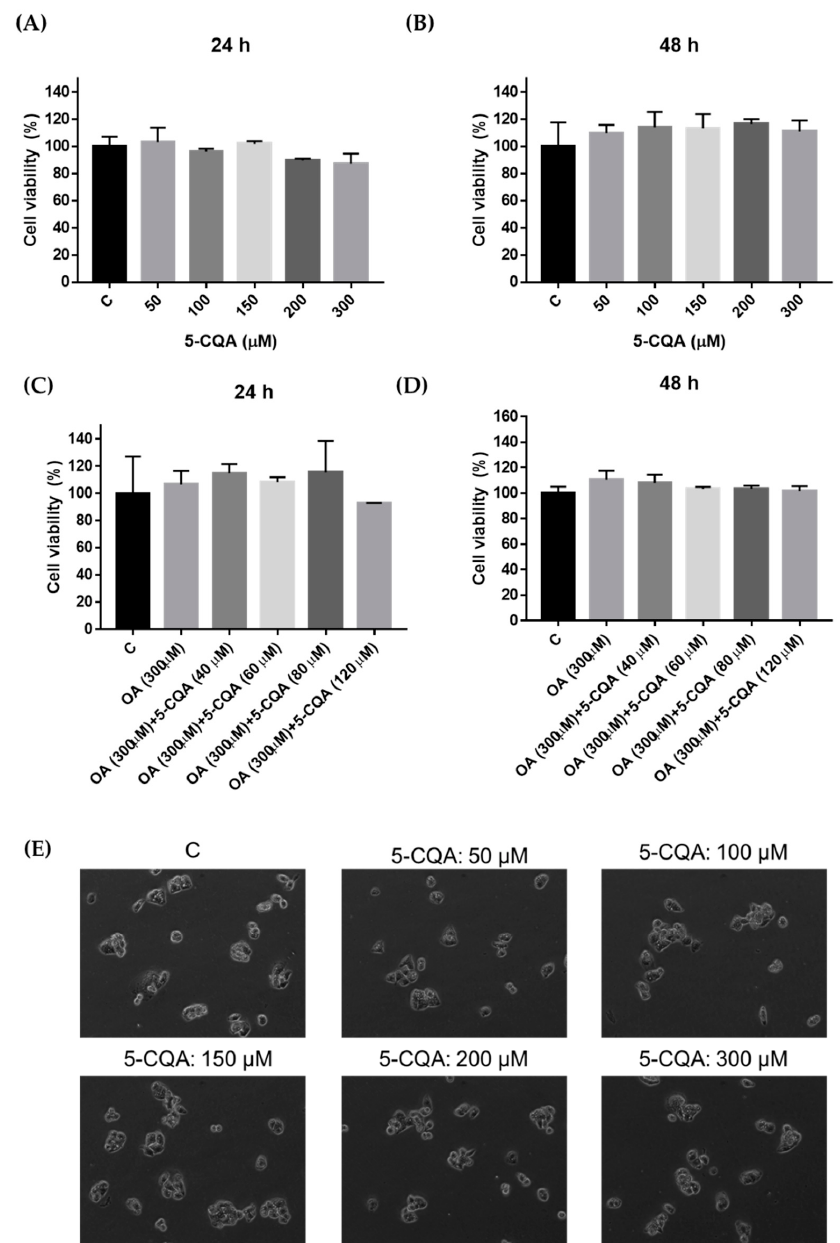
Figure 1. Cytotoxicity of HepG2 cells after treatment with 5-CQA. ( A ) Cultured HepG2 cells were treated with various concentrations of 5-CQA for 24 h and analyzed using the MTT assay. ( B ) Cultured HepG2 cells were treated with various concentrations of 5-CQA for 48 h and analyzed using the MTT assay. ( C ) Cultured HepG2 cells were co-treated with various concentrations of 5-CQA with OA (300 µ M) for 24 h and analyzed using the MTT assay. ( D ) Cultured HepG2 cells were co-treated with various concentrations of 5-CQA with OA (300 µ M) for 48 h and were then analyzed using the MTT assay. ( E ) Cells were treated with indicated concentrations of 5-CQA for 24 h and then the cell morphology was monitored by phase-contrast microscopy. The data are expressed as mean ± SD from three samples for each